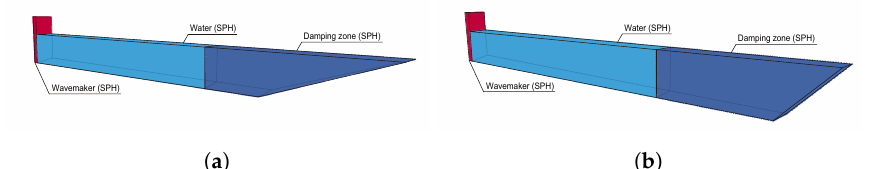
Figure 7. ( a ) Case III-1: numerical wave tank using a mass-weighted damping zone with beach slope of 1:1. ( b ) Case III-2: numerical wave tank using a mass-weighted damping zone with beach slope of 1:3. Table 5. Numerical wave tank models with different beach slopes. Case No. Beach Slope